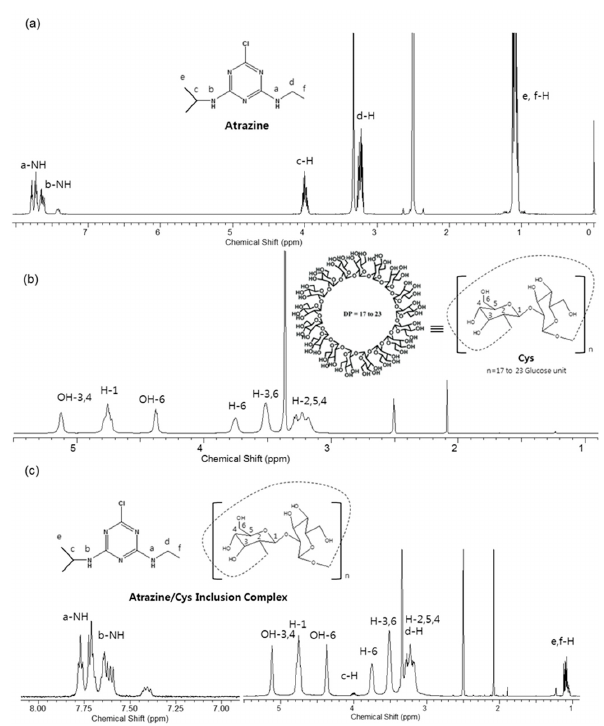
Figure 1. 1 H NMR spectra of ( a ) atrazine; ( b ) cyclosophoraoses (Cys); and ( c ) atrazine/Cys inclusion